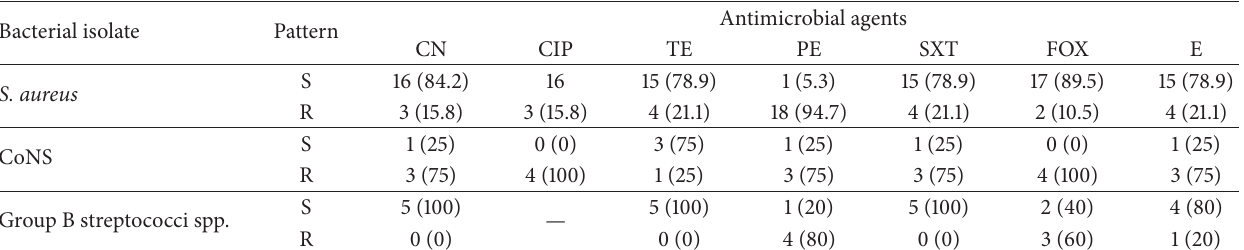
Table 4: Antibiotic susceptibility pattern of Gram positive bacterial isolates in postoperative surgical site infected patients in selected referral hospitals of Addis